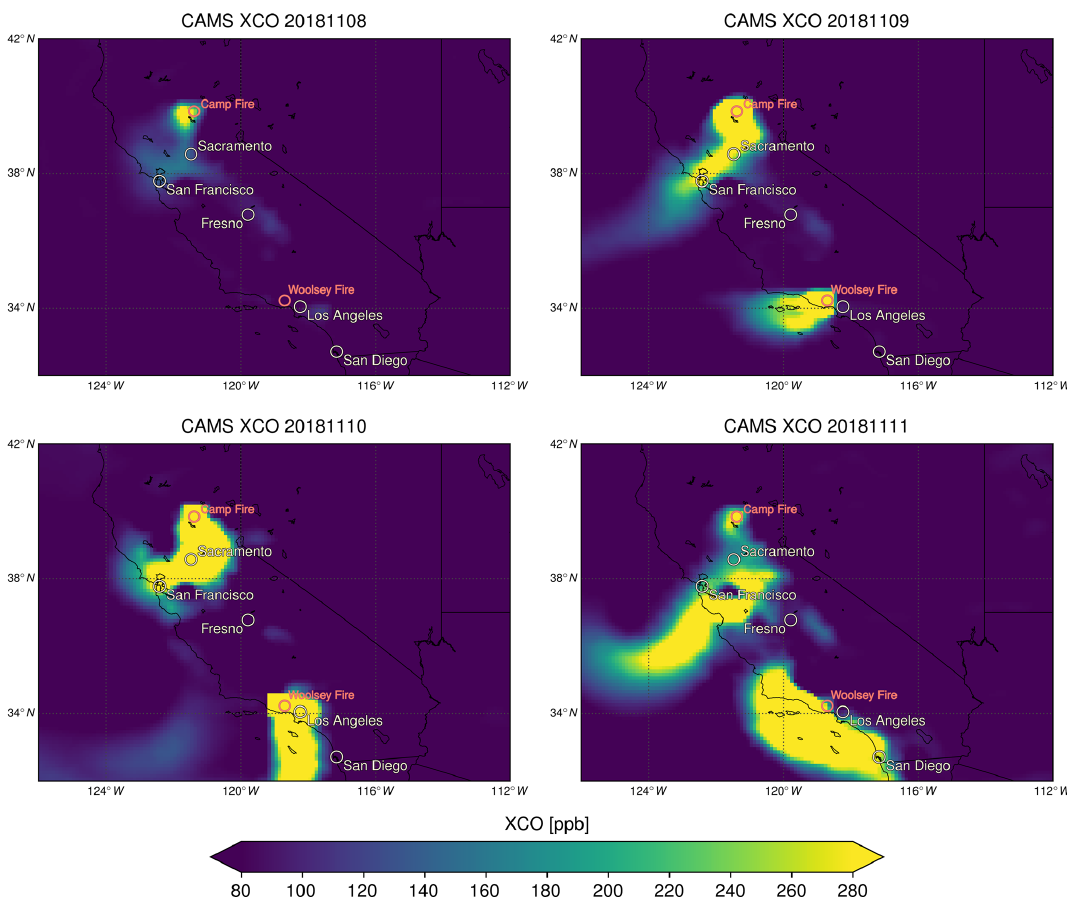
Figure 5. CAMS near-real-time CO analysis for the first days of the fires at 24:00UTC, corresponding to 16:00 local time (Pacific Standard